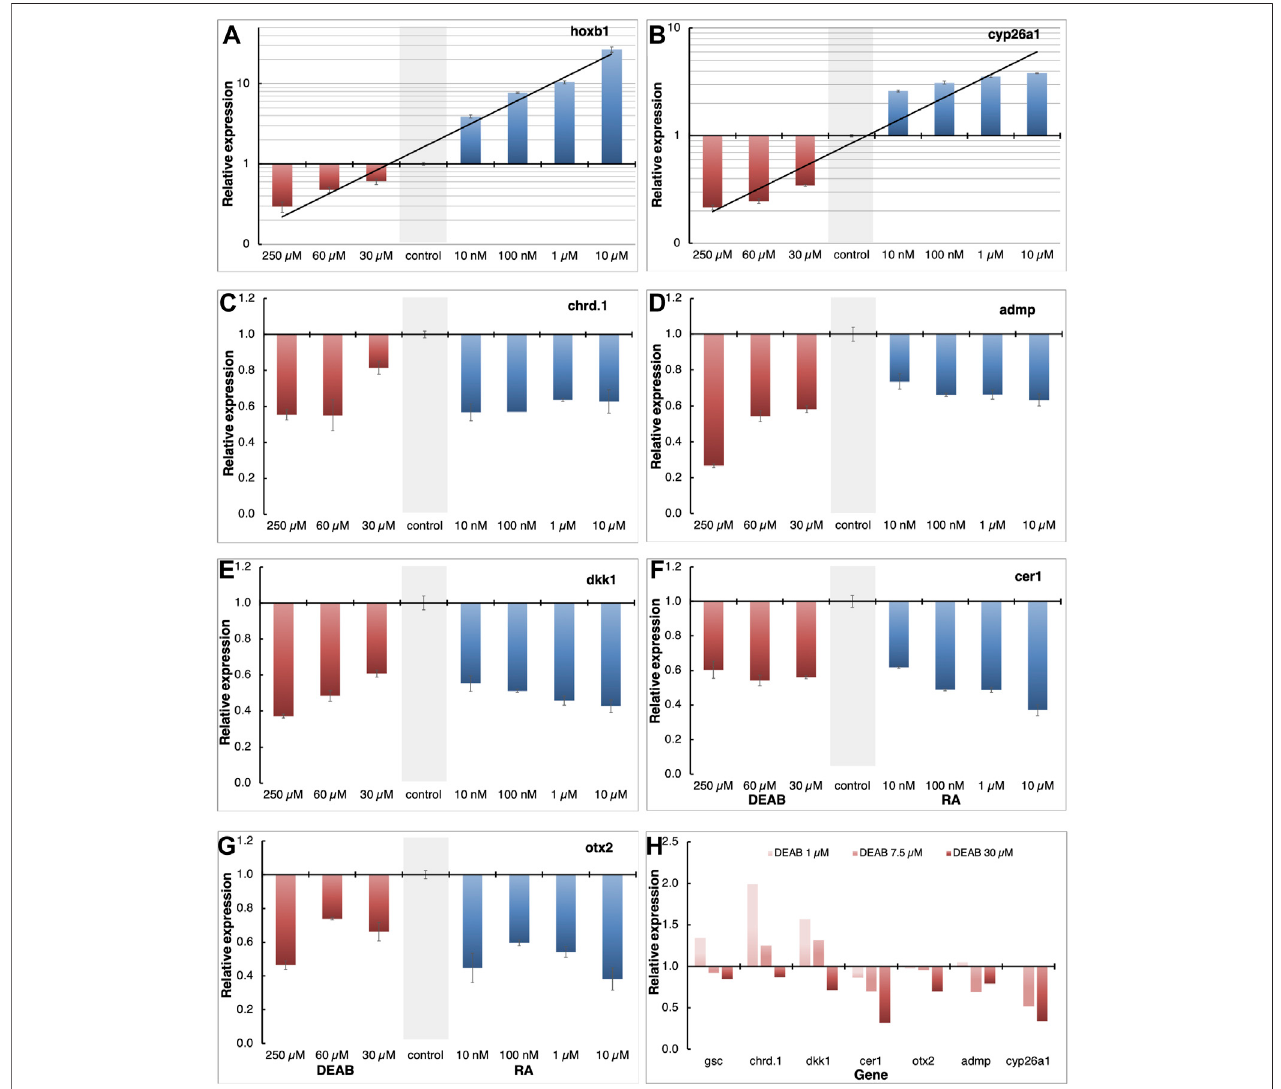
FIGURE 3 | Positive and negative regulation of organizer genes by RA. (A – G) Embryos were treated with increasing concentrations of atRA (10 nM – 10 μ M) or DEAB (30 – 250 μ M) from late blastula to early gastrula. Expression changes of hoxb1 (A) , cyp26a1 (B) , chrd.1 (C) , admp (D) , dkk1 (E) , cer1 (F) , and otx2 (G) were studied by qPCR. Samples were normalized to control expression levels (gray bar). (H) Fine titration of RA biosynthesis inhibition using DEAB (1 – 30 μ M). Expression changes were determined for gsc , cyp26a1 , chrd.1 , admp , dkk1 , cer1 , and otx2 by qPCR.